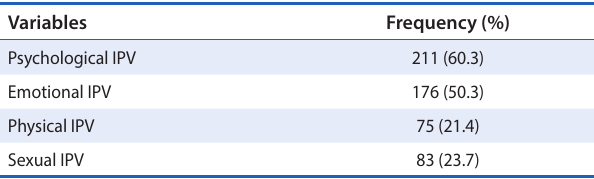
Table 3: Distribution of respondents with regard to forms of IPV*